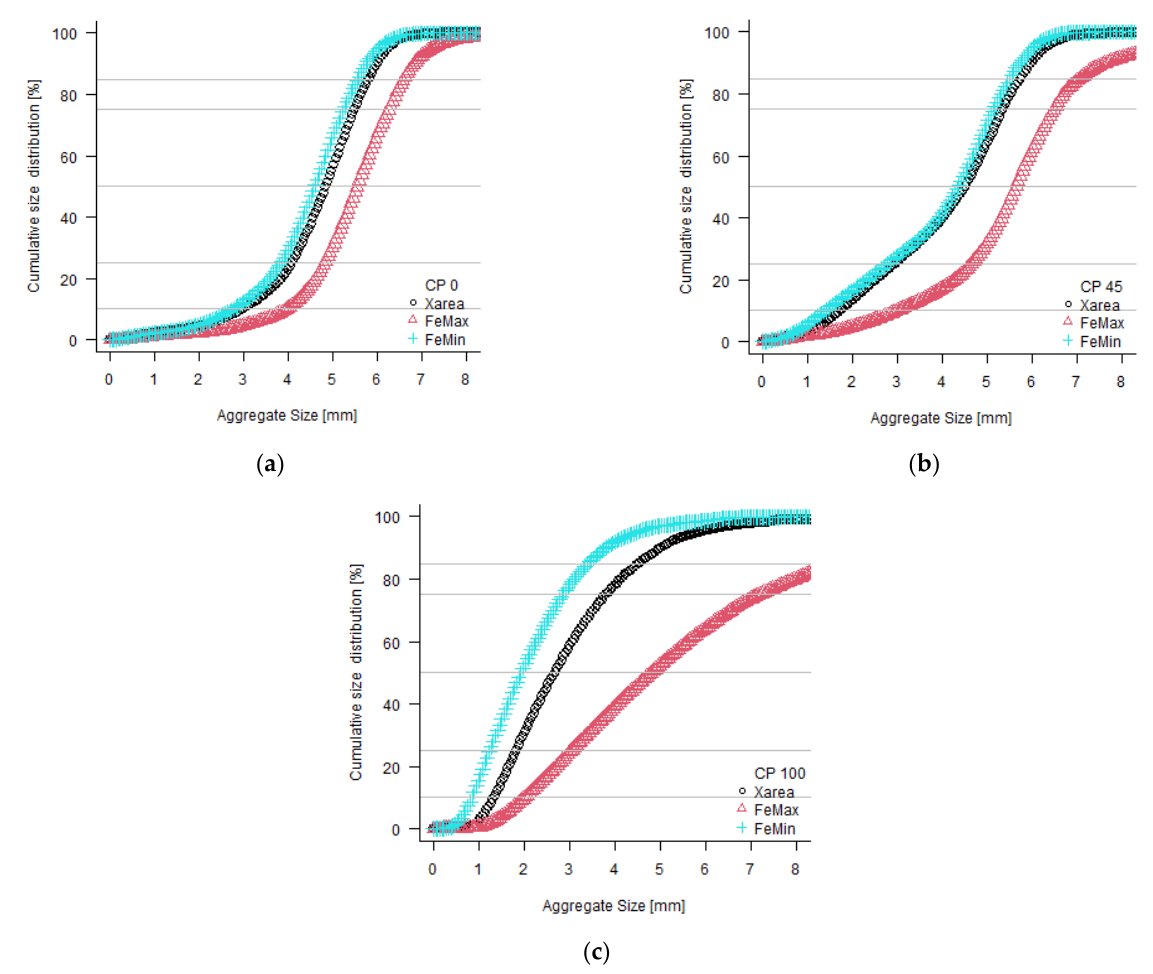
Figure 6. Average development of aggregate shape parameters with increasing cup plant ratio ( CP ) as cumulative size distribution Q. ( a ) CP 0 : EPS extracted from the commercial mix; ( b ) CP 45 : mix composition of 45 vol% milled cup plant aggregates and 55 vol% extracted EPS; ( c ) CP 100 : cup plant aggregates obtained by milling and sieving. The parameters are: Feret minimal diameter (FeMin) as width; equivalent circle radius (Xarea); Feret maximal diameter (FeMax) as length [ n = 4]. Considering the change in general shape parameters such as the width to length ratio ( W / L ) and sphericity (SPHT) in Table 3 at the cumulative readout Q, the